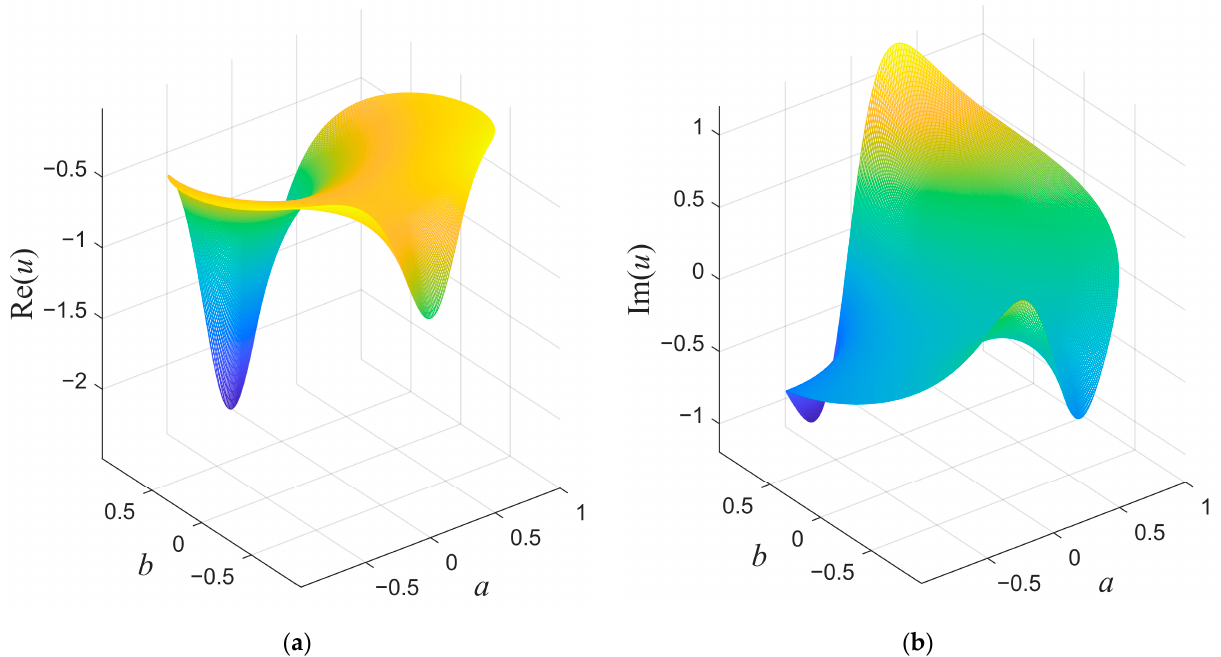
Figure 1. ( a ) Real part of 𝑢 ; ( b ) Imaginary part of 𝑢 . Obtained at k = 1 and using “+” in corresponding equations.